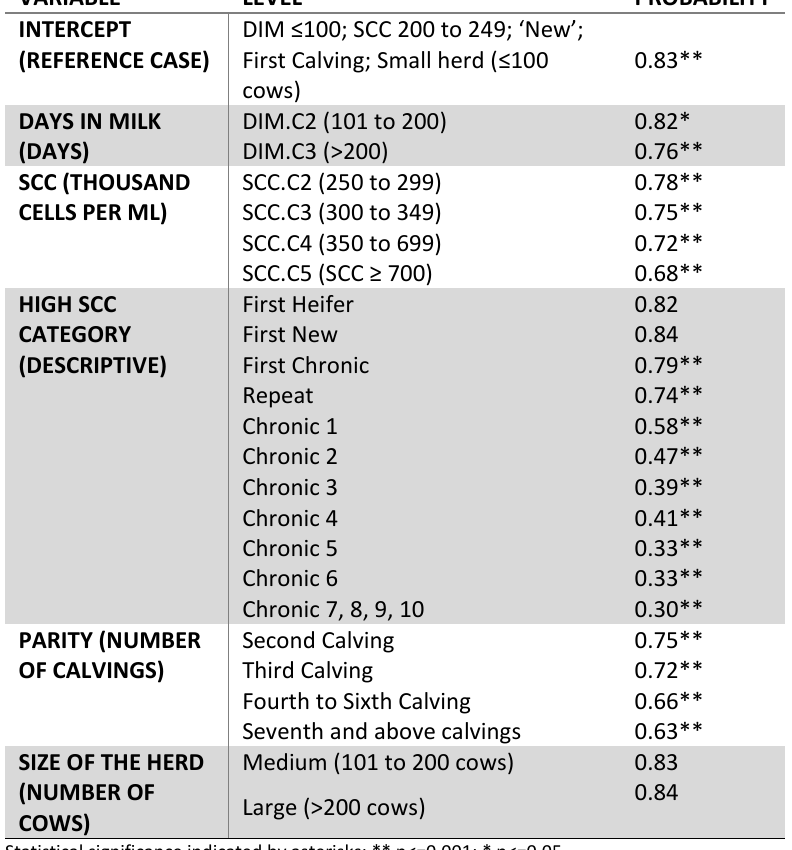
Examples of estimating the expected recovery probabilities for specific high SCC cases using the output of the regression